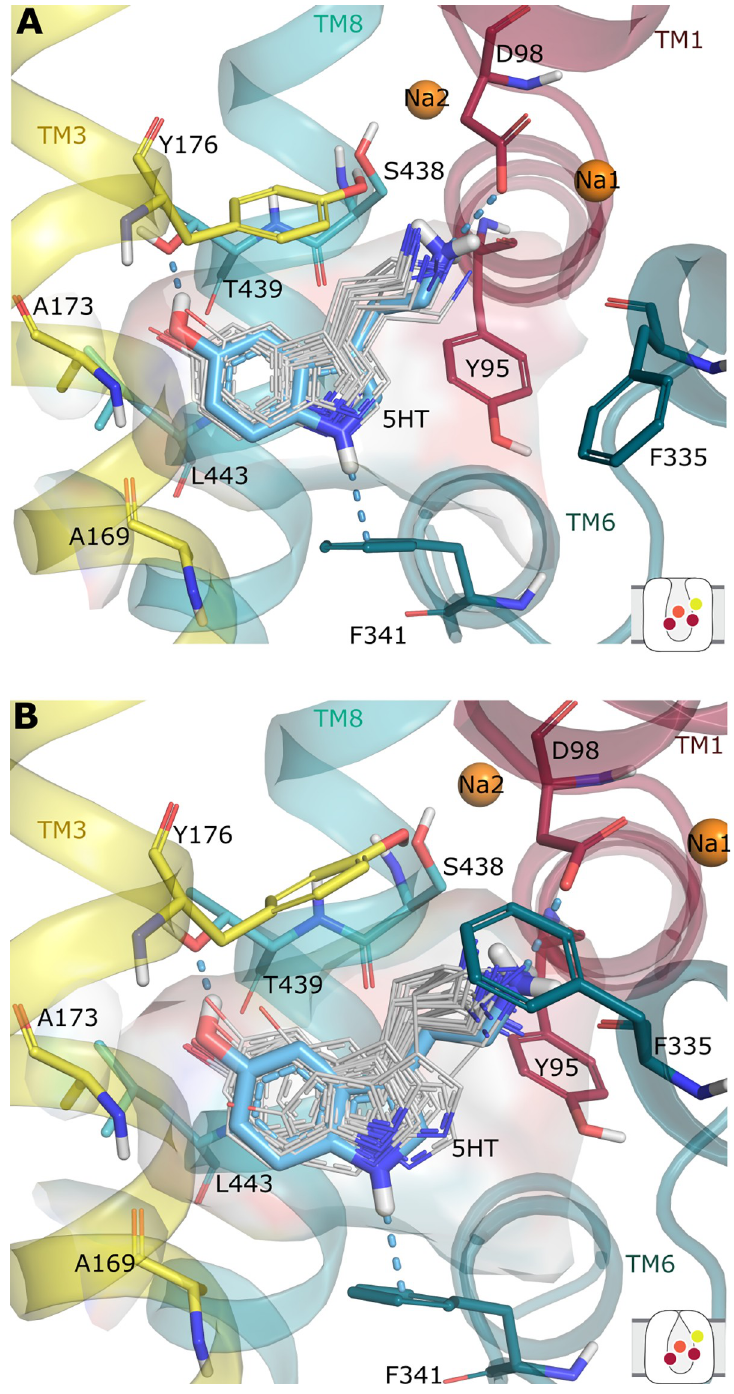
Fig 5. Conformations of 5HT in the most-favored clusters from induced-fit docking. Selected docking pose of 5HT (blue) within the cluster in A) the outward-open structure (PDB ID 5I71, 30 poses) and B) the outward-occluded model (57 poses). Previously-identified protein-ligand interactions with D98, F341, and T439 are observed in both cases (blue dashes).